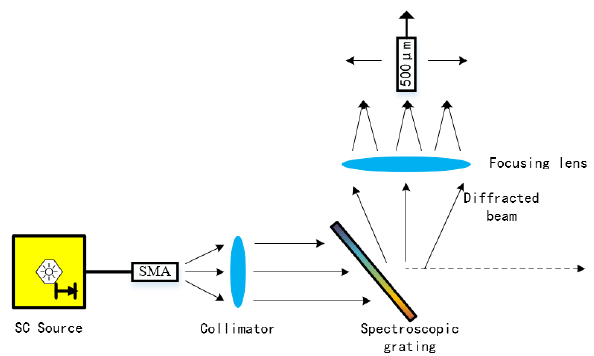
Figure 10. Schematic of the simple spectroscopic device.